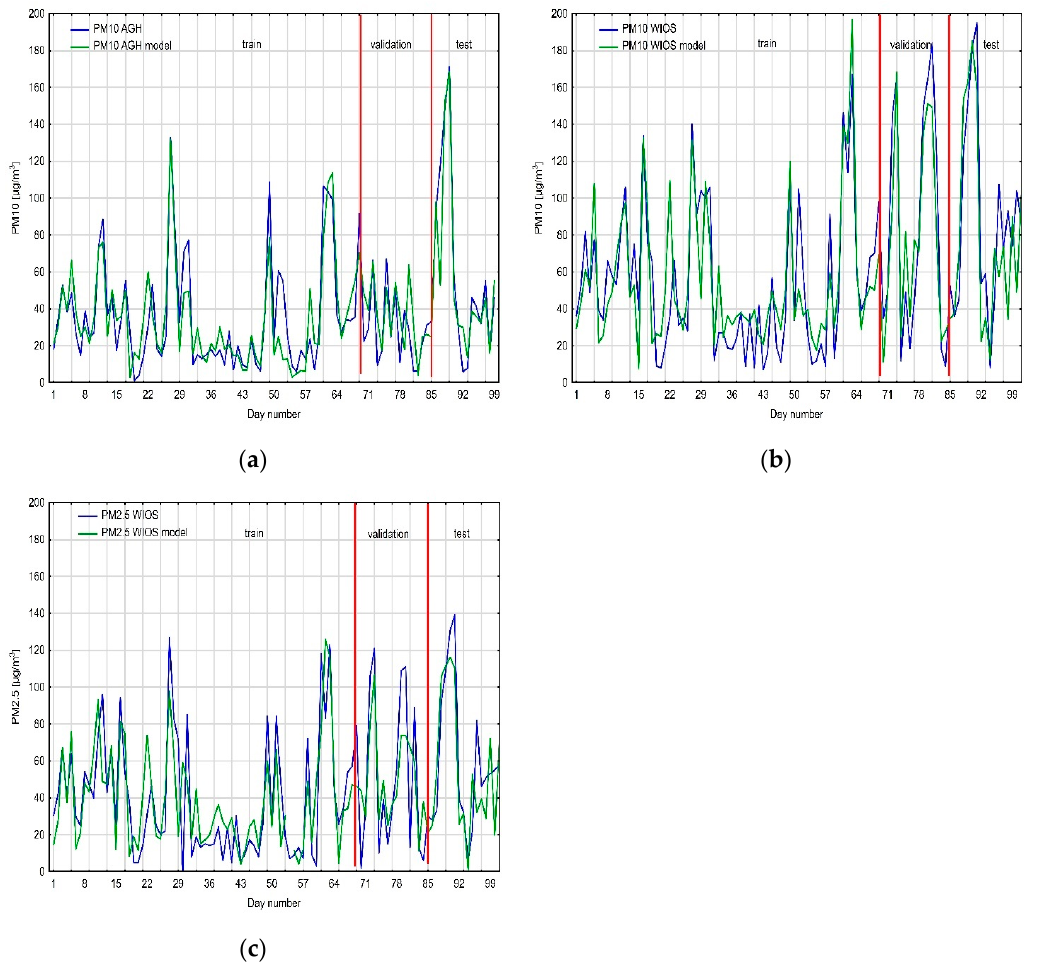
Figure 7. Comparison of the obtained models against real data: ( a ) PM 10 AGH, ( b ) PM 10 WIOS, and ( c ) PM 2.5 WIOS.